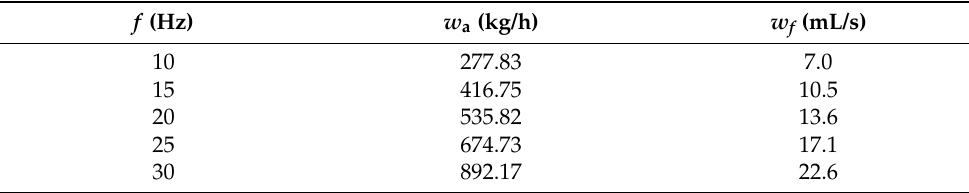
Table 1. Airflow and fuel flow in PDC at different operating frequencies.